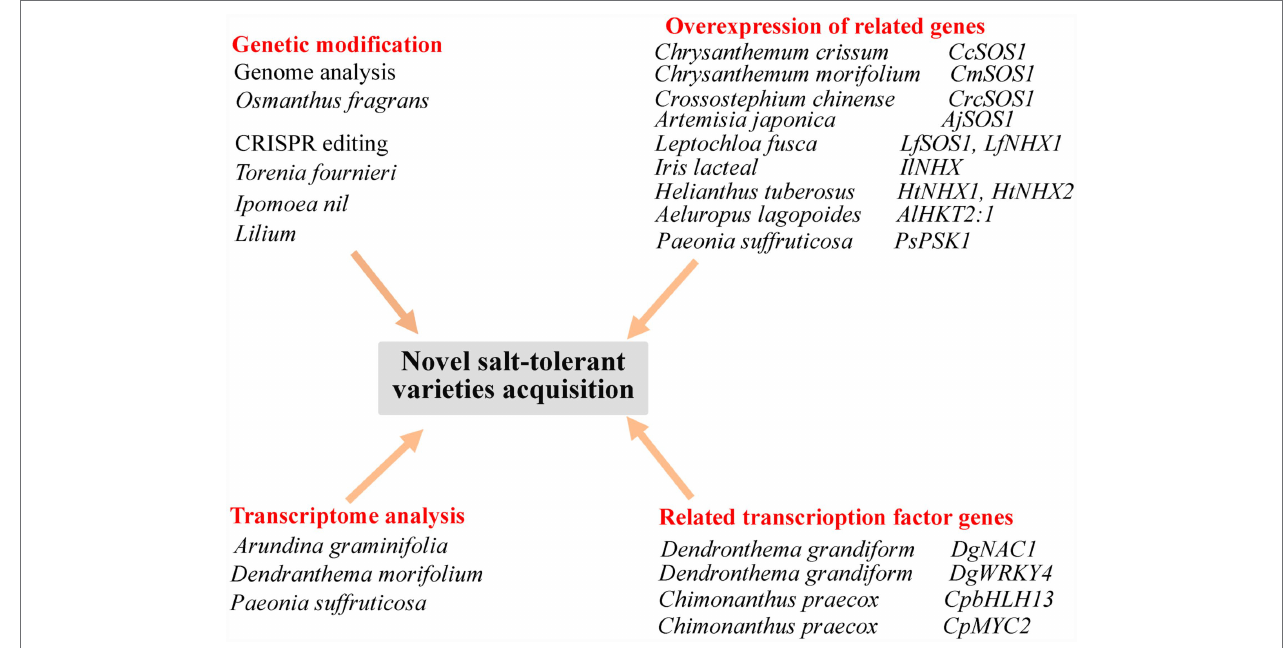
FIGURE 2 | Summary of approaches for the acquisition of novel, salt-tolerant ornamental flowering plant varieties. CcSOS1 , cytomembrane Na + /H + antiporter gene from Chrysanthemum crissum ; CmSOS1 , cytomembrane Na + /H + antiporter gene from Chrysanthemum morifolium ; CrcSOS1 , cytomembrane Na + /H + antiporter gene from Crossostephium chinense ; AjSOS1 , cytomembrane Na + /H + antiporter gene from Artemisia japonica ; LfSOS1 , cytomembrane Na + /H + antiporter gene from Leptochloa fusca ; LfNHX1 , tonoplast Na + /H + antiporter gene from Leptochloa fusca ; IlNHX , tonoplast Na + /H + antiporter gene from Iris lacteal ; HtNHX1 and HtNHX2 , tonoplast Na + /H + antiporter gene from Helianthus tuberosus ; AlHKT2:1 , high-affinity K + transporter gene from Aeluropus lagopoides ; PsPSK1 , a SKP1-like gene homologue from Paeonia suffruticosa ; DgNAC1 , NAC transcription factor gene from Dendronthema grandiform ; DgWRKY4 , WRKY transcription factor gene of from Dendronthema grandiform ; CpbHLH13 , bHLH transcription factor gene from Chimonanthus praecox ; and CpMYC2 , bHLH transcription factor gene from Chimonanthus praecox